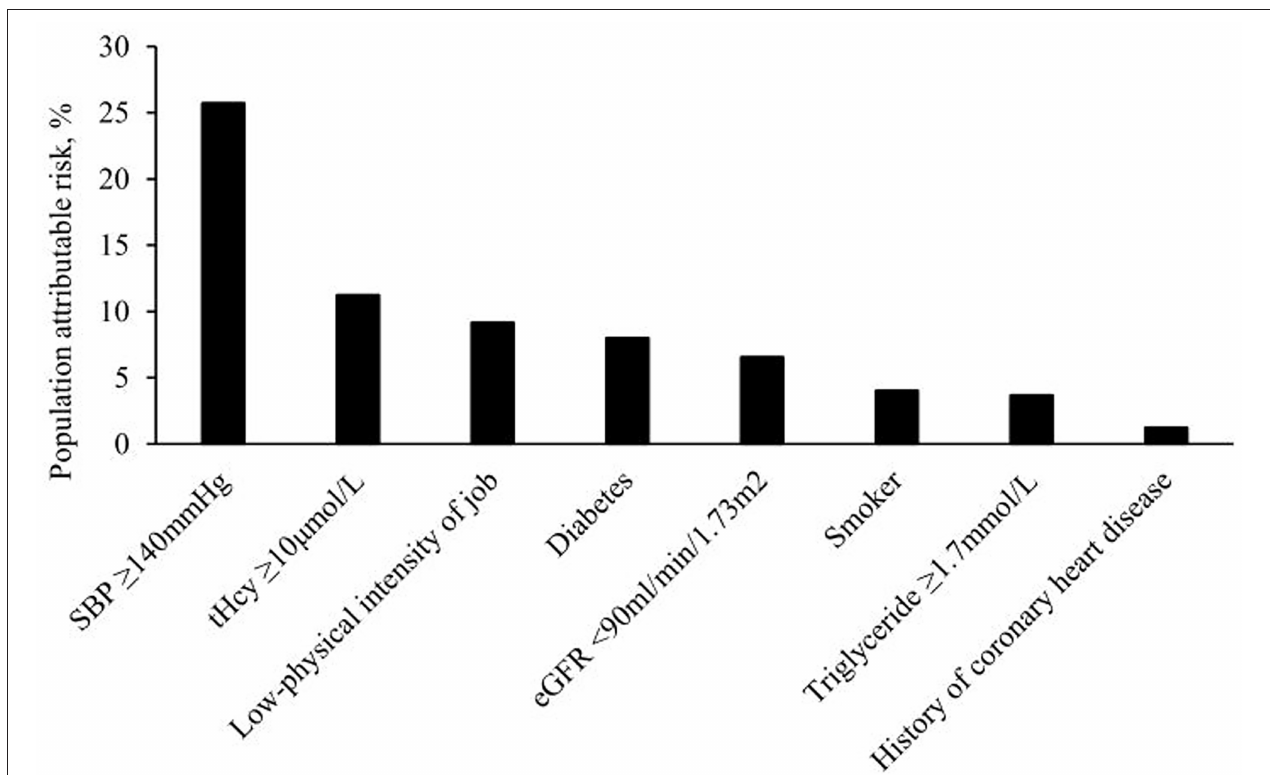
FIGURE 3 | Population-attributable risks of traditional risk factors and tHcy for first